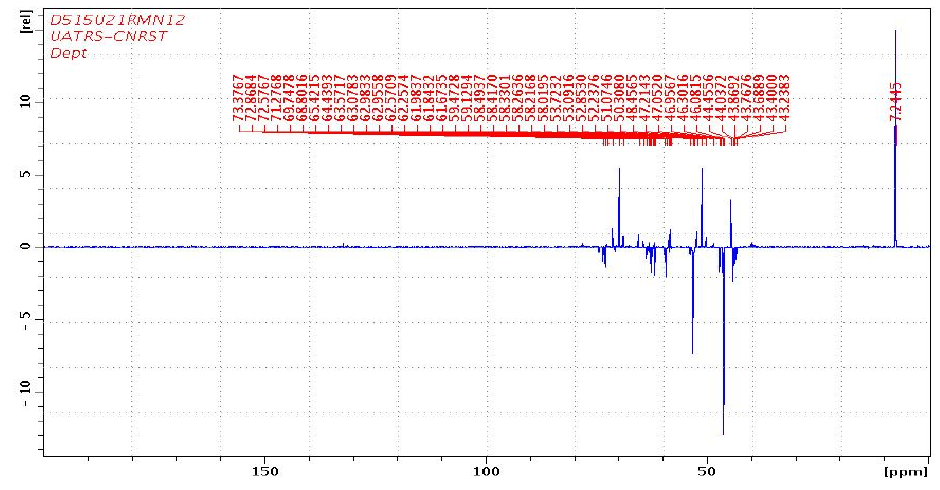
Figure 2. NMR spectrum of TGP synthesized.